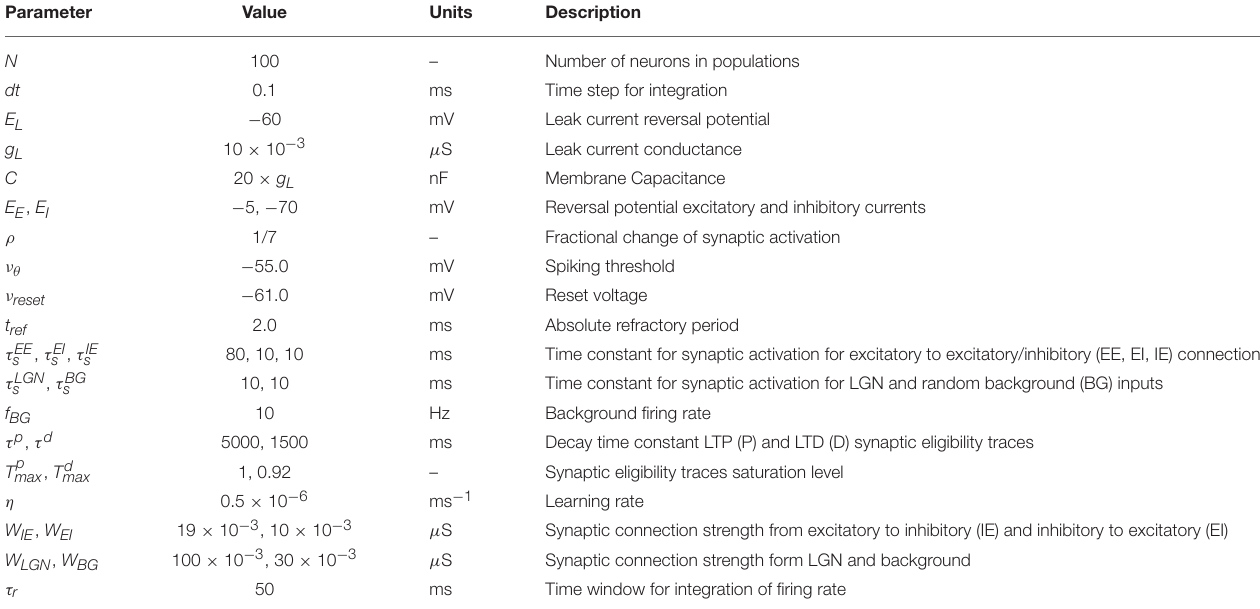
TABLE 1 | Description and values of model parameters used in